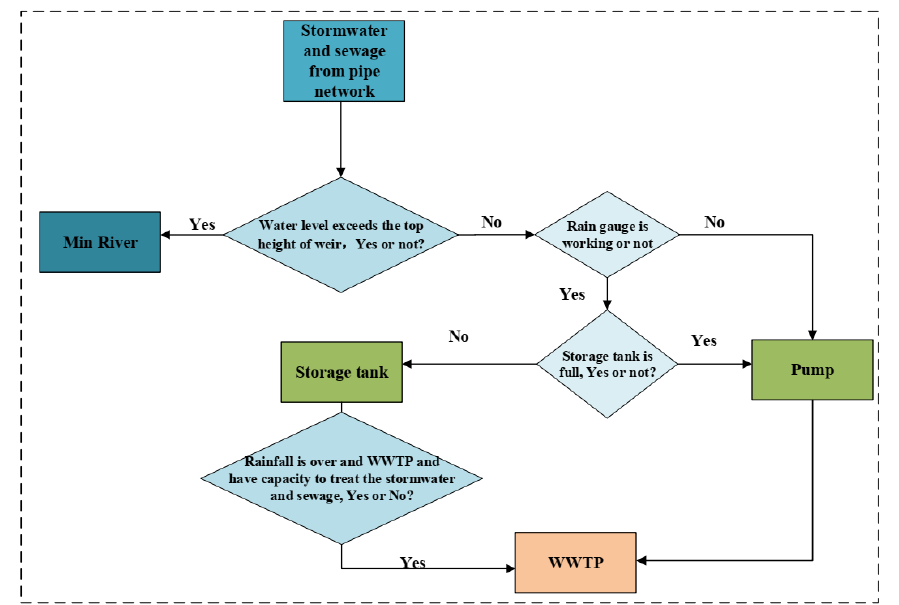
Figure 8. Working flow chart of traditional scheme.